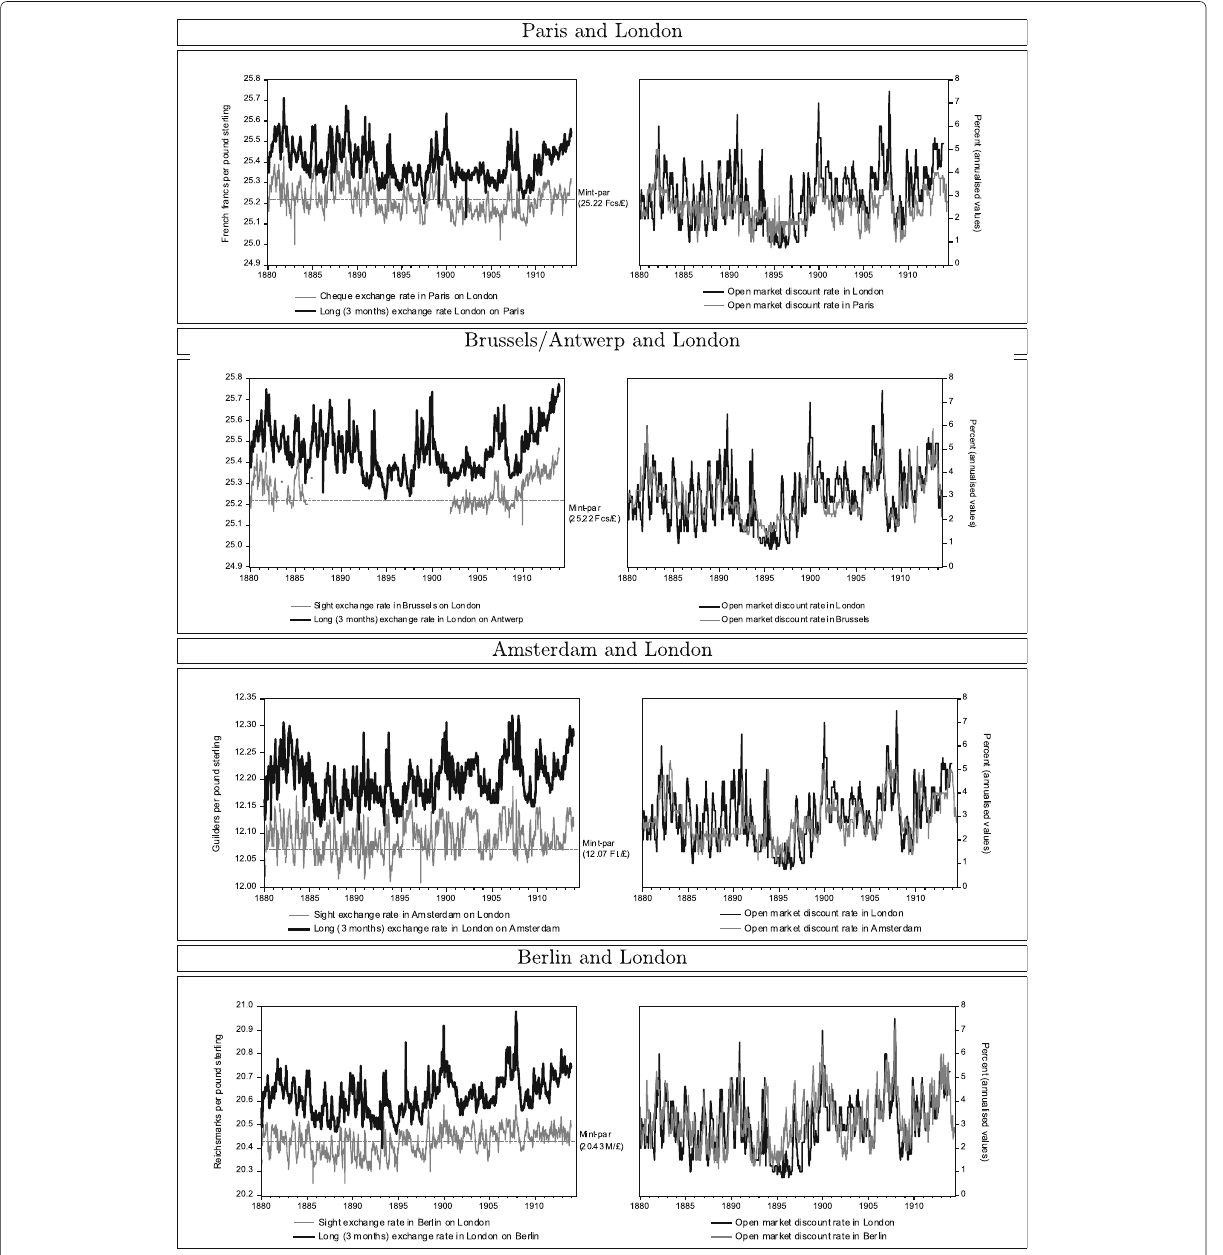
pp. 80ff.; Thomas 1921, pp. 78ff., Einzig 1967, p. 6). Although they give rise to an implicit forward exchange rate, it is important to recognise that long-bills differ from a modern forward contract in terms of also encapsulating a short-term credit by requiring an immediate payment from the buyer, who is promised to receive a certain amount of foreign currency back upon maturity (see Clare 1895, ch. 12). Hence, interest-parity conditions